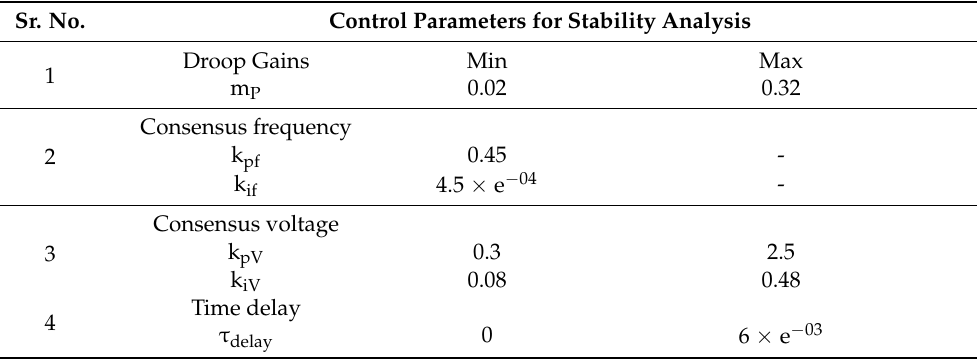
Table 1. System parameters for stability analysis and experimental prototype. Sr.